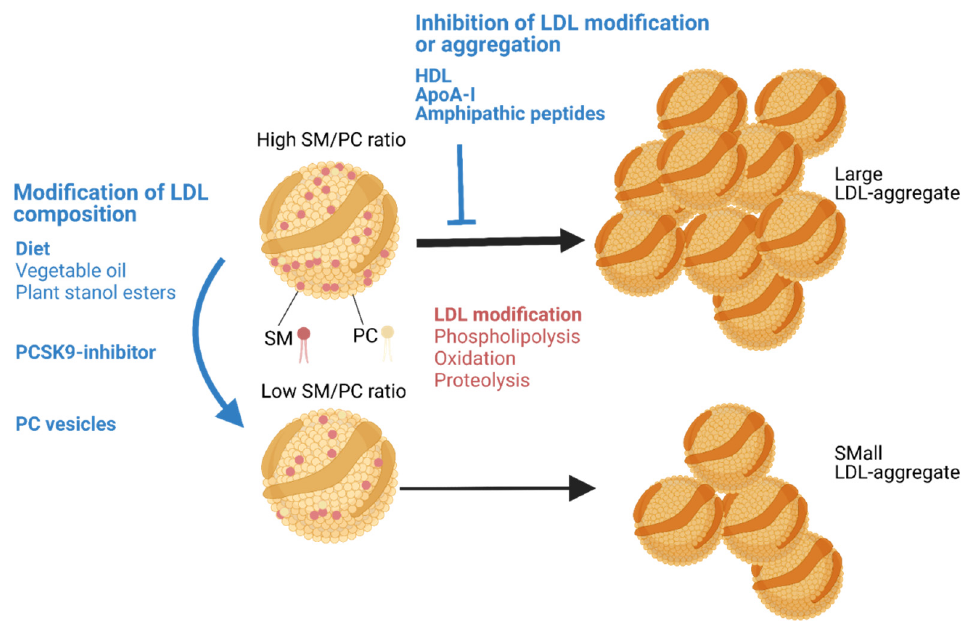
Figure 2. Aggregation LDL particles and its inhibition. LDL particles aggregate when they are modified by lipolytic or proteolytic enzymes or when they are exposed to pro-oxidative enzymes or agents. The aggregation susceptibility of LDL particles can be reduced (1) by modifying the lipid composition of the particles or (2) by inhibiting the modification of LDLs or stabilizing the modified LDL particles. The composition of circulating LDL particles can be modified by dietary changes and medications, such as PCSK9 inhibitors. These changes reduce the proportion of SM on the LDL particle surface. In a mouse model, injection of PC vesicles into the circulation has been shown to reduce the proportion of SM in LDL. Treatment of LDL particles in vitro by HDL, apoA-I, or amphipathic peptides can inhibit LDL modification or stabilize the surface of the modified LDL particles and directly inhibit their aggregation. Image created with BioRender.